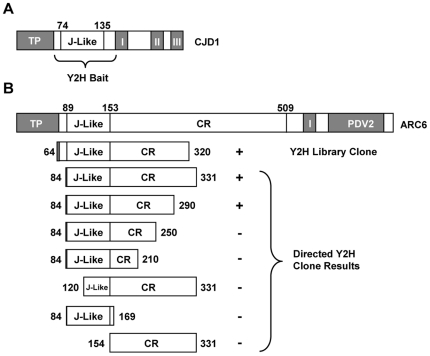
Schematic representation of selected yeast 2-hybrid clones and results.TP, transit peptide; Roman numerals, transmembrane domains; CR, conserved region; PDV2, PDV2 binding domain. A, CJD1 protein. The amino terminal soluble portion (amino acids 60–164) was used as the bait. This peptide includes the J-like domain (amino acids 74–135). B, ARC6 clones and Y2H results. Top drawing: modular organization of ARC6. Second drawing: representative clone identified by library screening. This clone has the full J-like domain and the shortest CR domain of the six clones recovered (see Table 2 for details of other clones). Constructs defined by bracket: results from directed Y2H screening of truncated ARC6 proteins with positive and negative results indicated with ‘+’ and ‘−’, respectively.